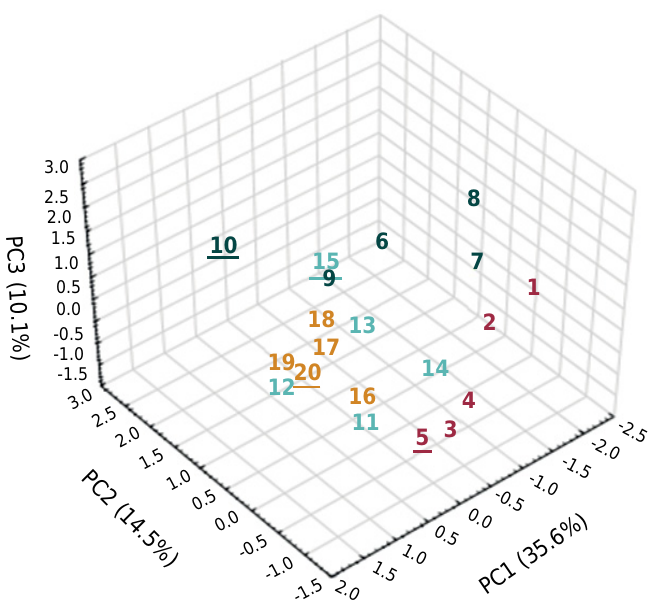
Figure 6. Scores from the first three principal components obtained by Principal Component Analysis (PCA), showing the grouping of the samples according to the relative contribution of the SEM-EDS and PSD data. Note: Red samples – Santa Cândida, Green samples – Guarani, Blue samples – Guaraituba, Yellow samples – Boa Vista, neighborhoods from Curitiba and Colombo, Paraná (Table 1); samples underlined refer to the suspect.